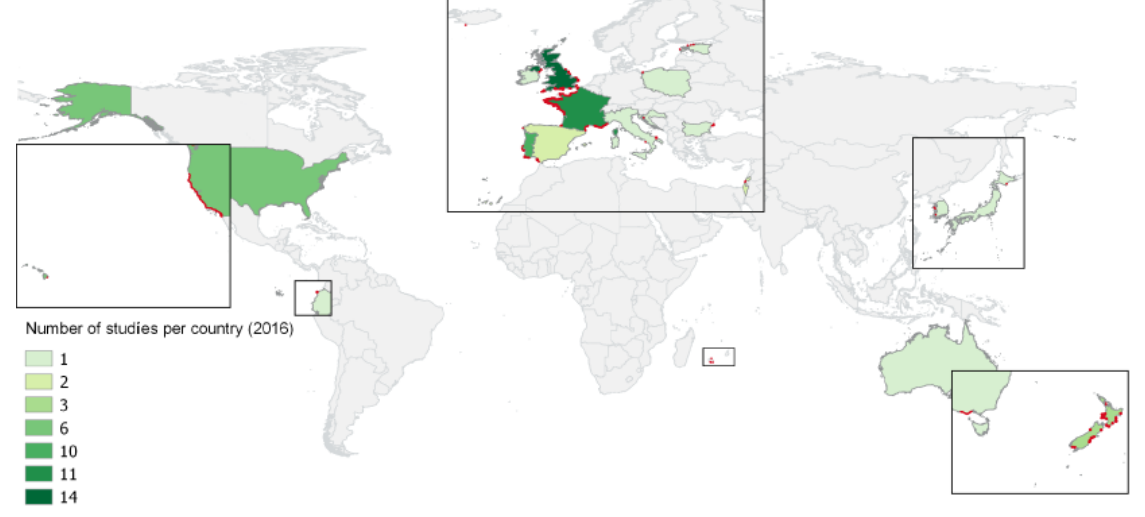
Figure 4. Cliff site locations (red dots) and number of studies contained in the GlobR2C2 database by country (published before 2016).